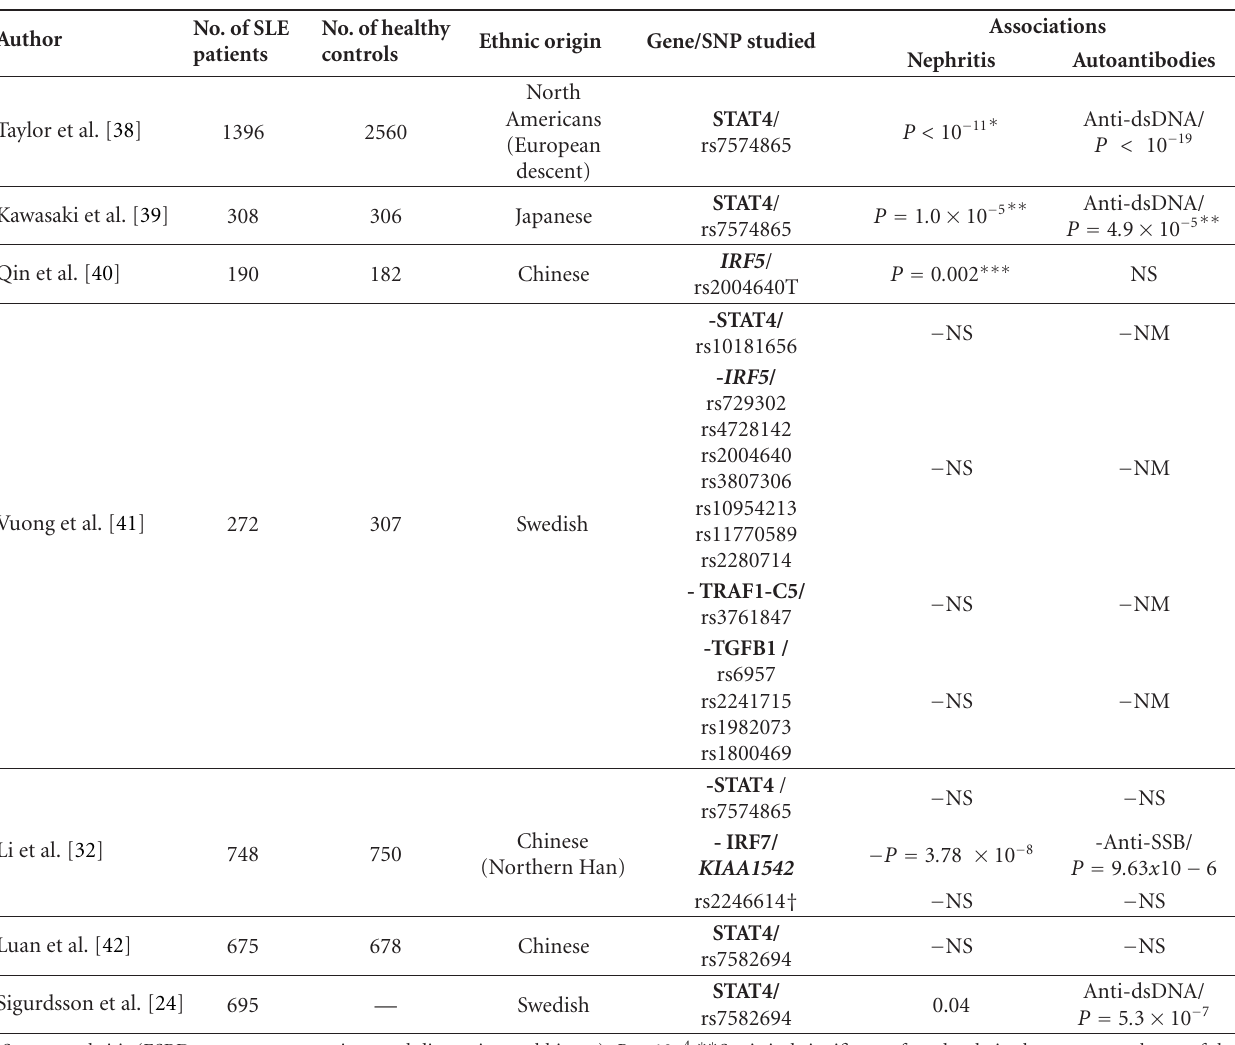
Table 2: Genetic studies investigating the association between several SNPs and both lupus nephritis and specific auto-antibodies in di ff erent ethnic